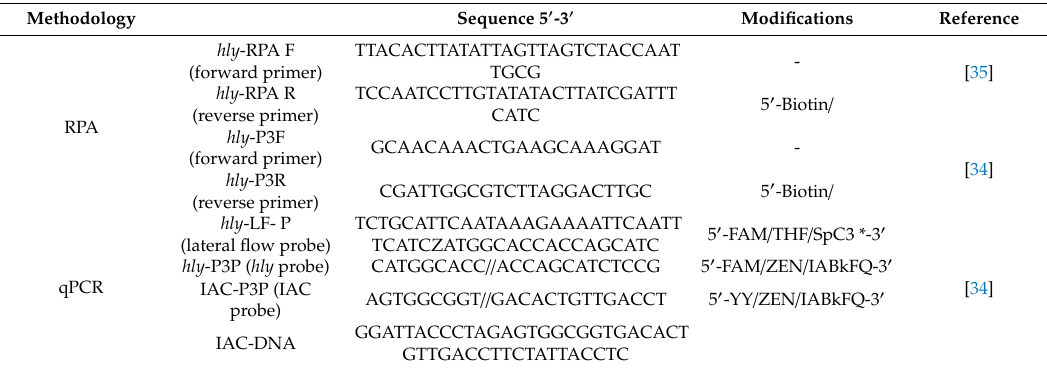
Table 2. Primer used in RPA and qPCR